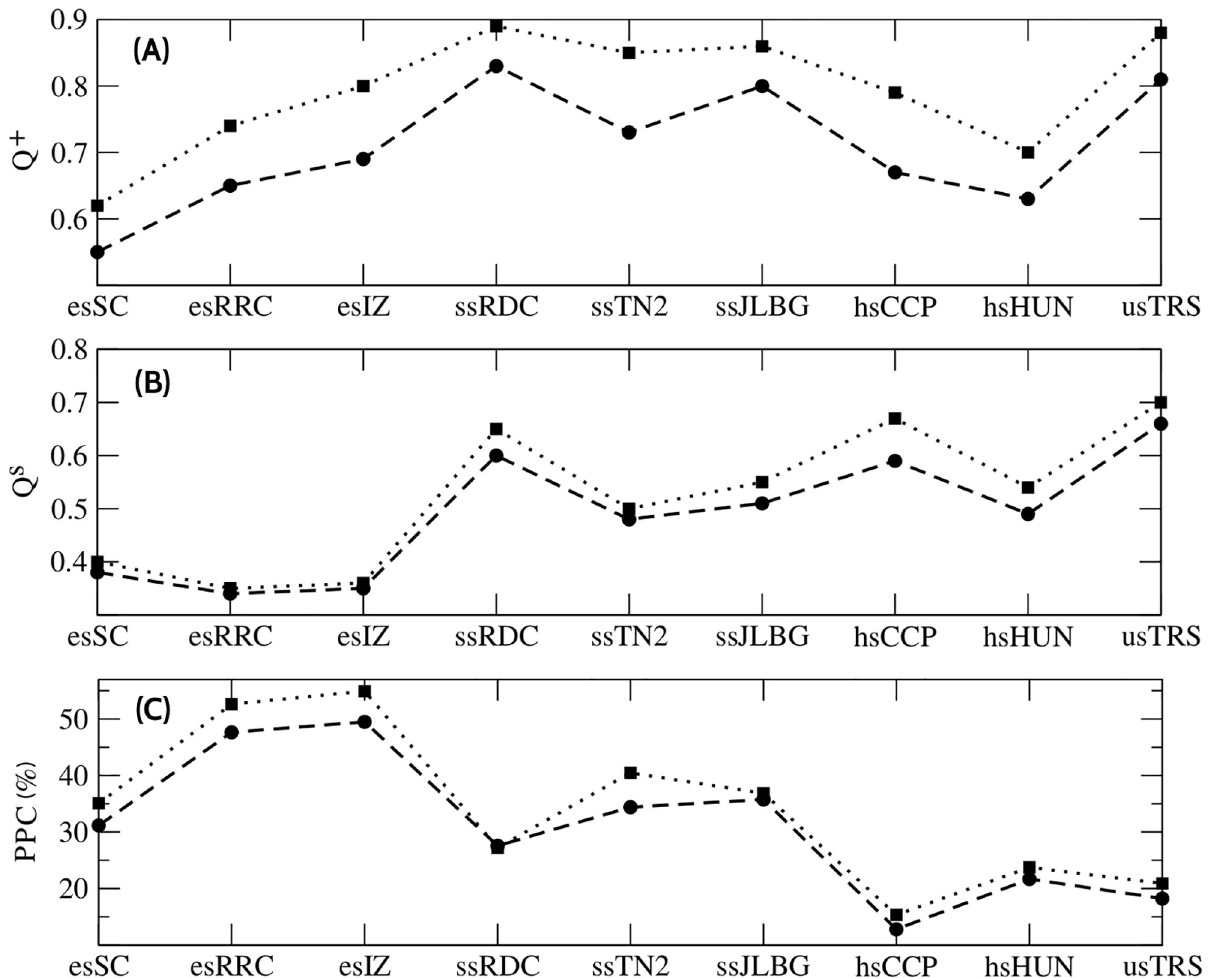
Fig 9. Modularity values. (A) Q + values for Newman (circles) and greedy (squares) methods. (B) Q -signed values for Newman (circles) and greedy (squares) methods. (C) Percentage of negative links perturbation in the communities (PPC) for Newman (circles) and greedy (squares) methods. Each greedy value was obtained after 300